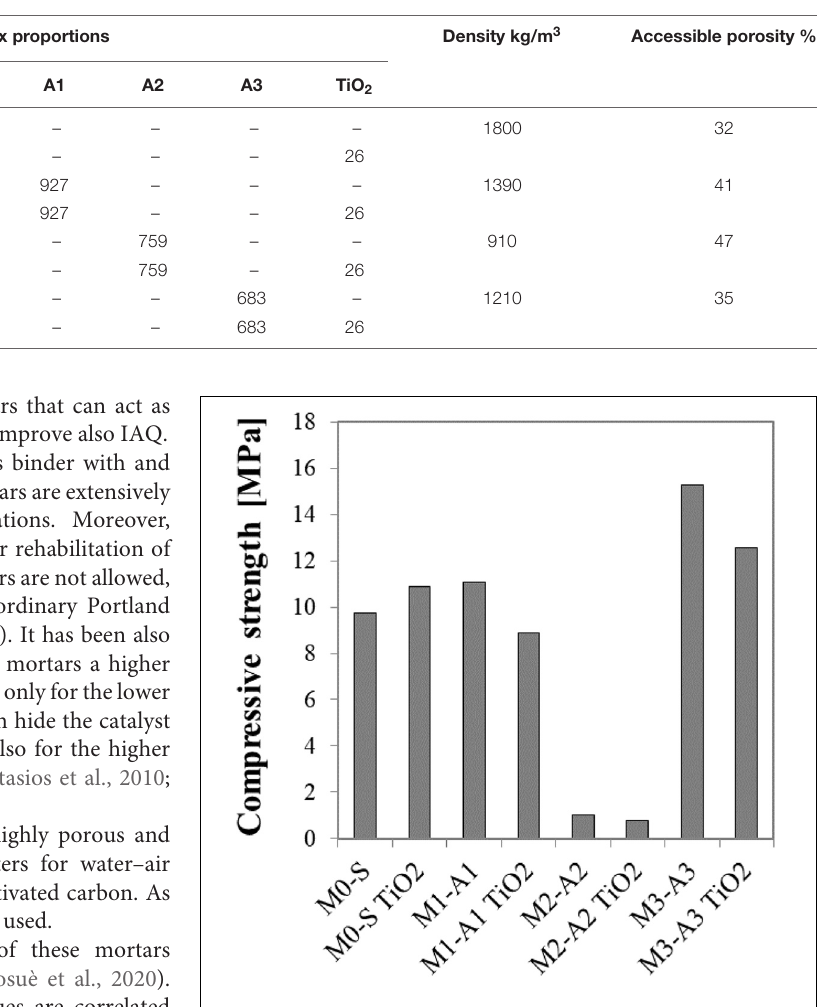
FIGURE 2 | Compressive strength of hydraulic lime-based